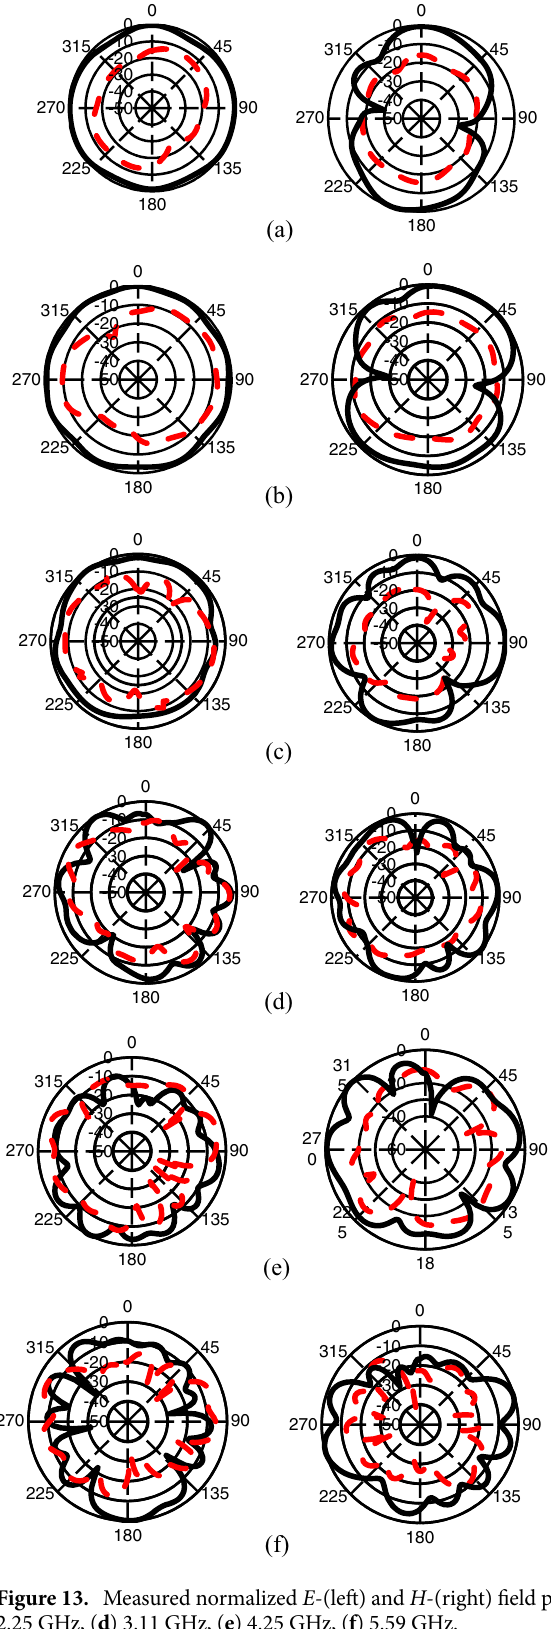
Figure 13. Measured normalized E -(left) and H -(right) field patterns at ( a ) 863 MHz, ( b ) 1.51 GHz, ( c ) 2.25 GHz, ( d ) 3.11 GHz, ( e ) 4.25 GHz, ( f ) 5.59